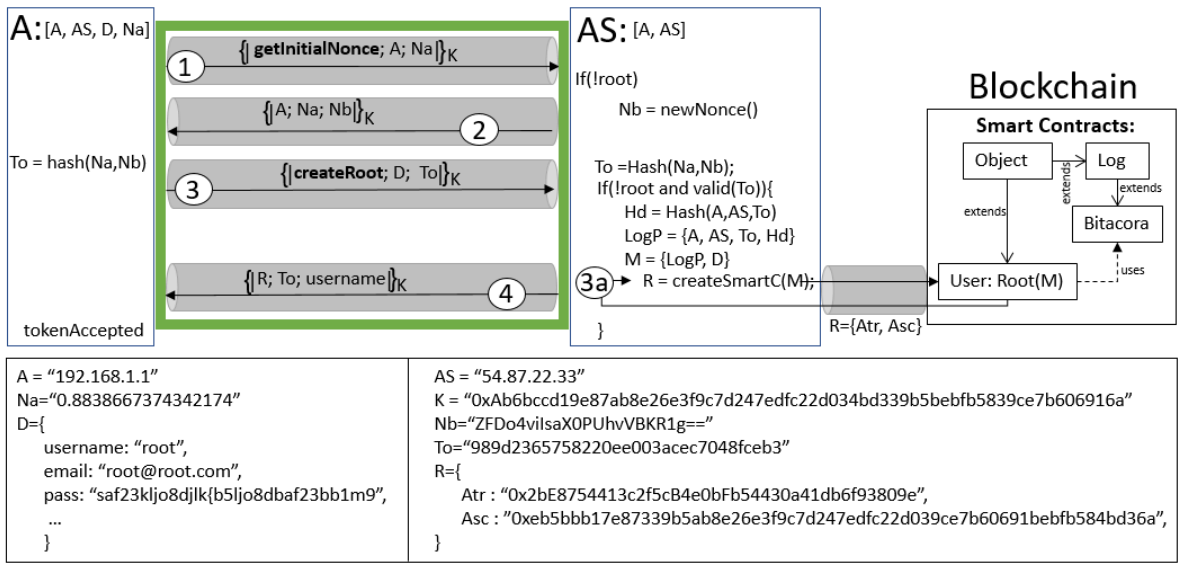
Figure 3. Root creation: a run of the protocol without anomalies and the interaction with the